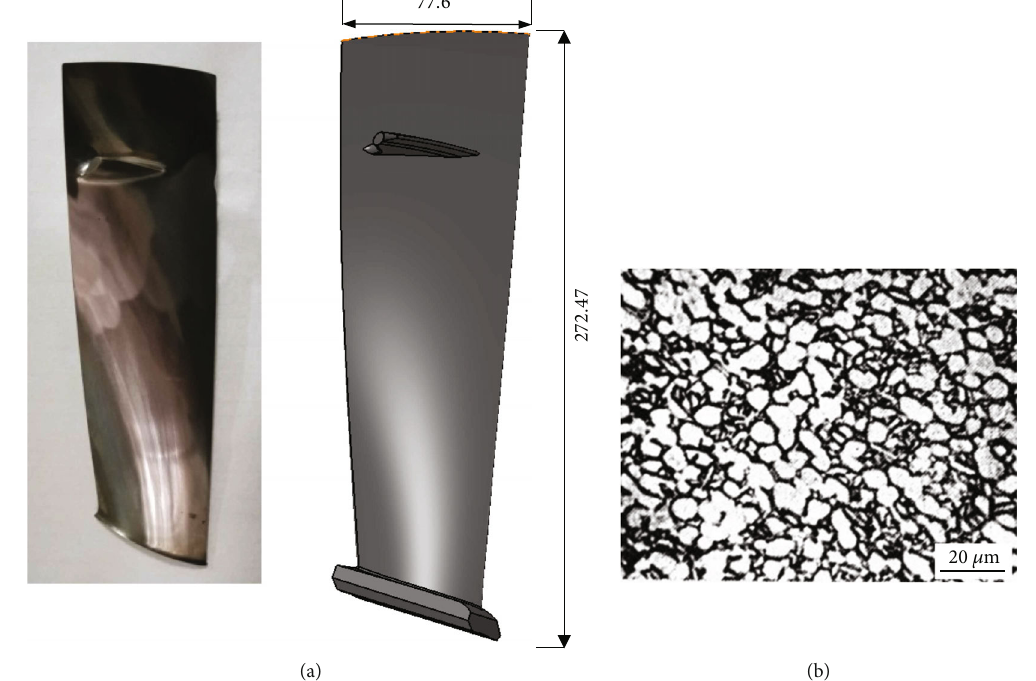
Figure 1: (a) Photographs of titanium alloy blade; (b) BT3-1 microstructure showing primary α and transformed β phases.